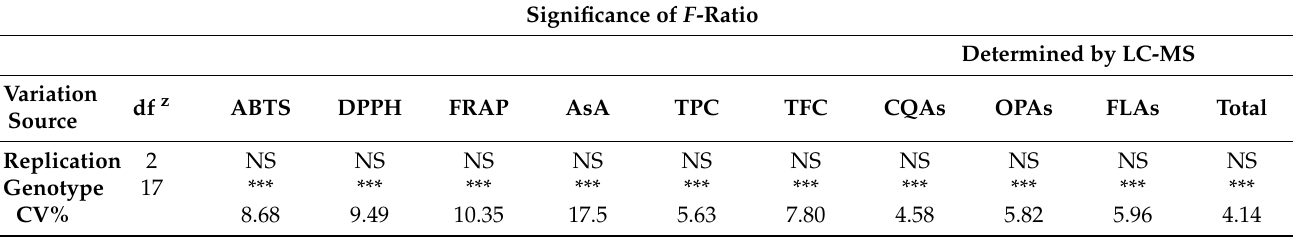
Table 2. Results of an analysis of variance applied on the evaluated bioactive compounds, antioxidant capacity parameters, and phenolic groups identified by an LC-MS analysis of the aboveground portion of 18 native Greek rock samphire genotypes. F-ratios’ significance is given for the effects exerted by replication and rock samphire